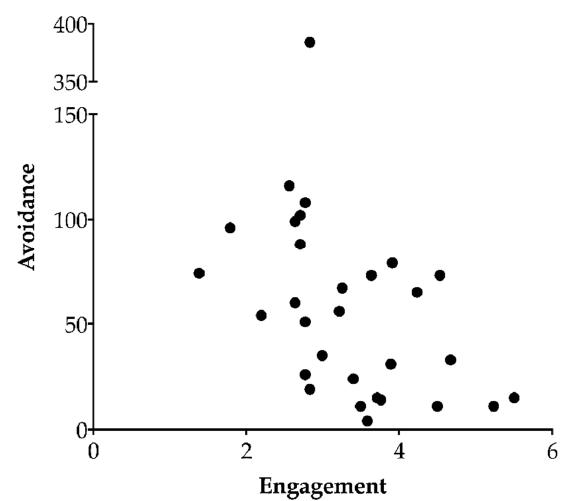
Figure 2. The relationship between avoidance and engagement levels (log transformed) of dairy heifers (n = 30) regrouped with unfamiliar conspecifics. Agonistic behaviors were recorded continuously during the first 24 h after heifers were introduced into a new group. More engaged individuals displayed less avoidance (Wald test on a linear mixed-effects model with host group as a random effect; p = 0.02). The extreme point for avoidance was capped in the model at the second highest value + 1. More engaged heifers spent more time feeding ( F 1,21 = 10.20, β = 0.20, p = 0.0044), but there was no relation between engagement and time spent resting ( F 1,21 = 0.068, β = 0.39, p = 0.80). More avoidant heifers spent less time feeding ( F 1,21 = 13.51, β = − 0.047, p = 0.0014; Figure 3), and less time resting ( F 1,21 = 8.017, β = − 0.11, p = 0.01).